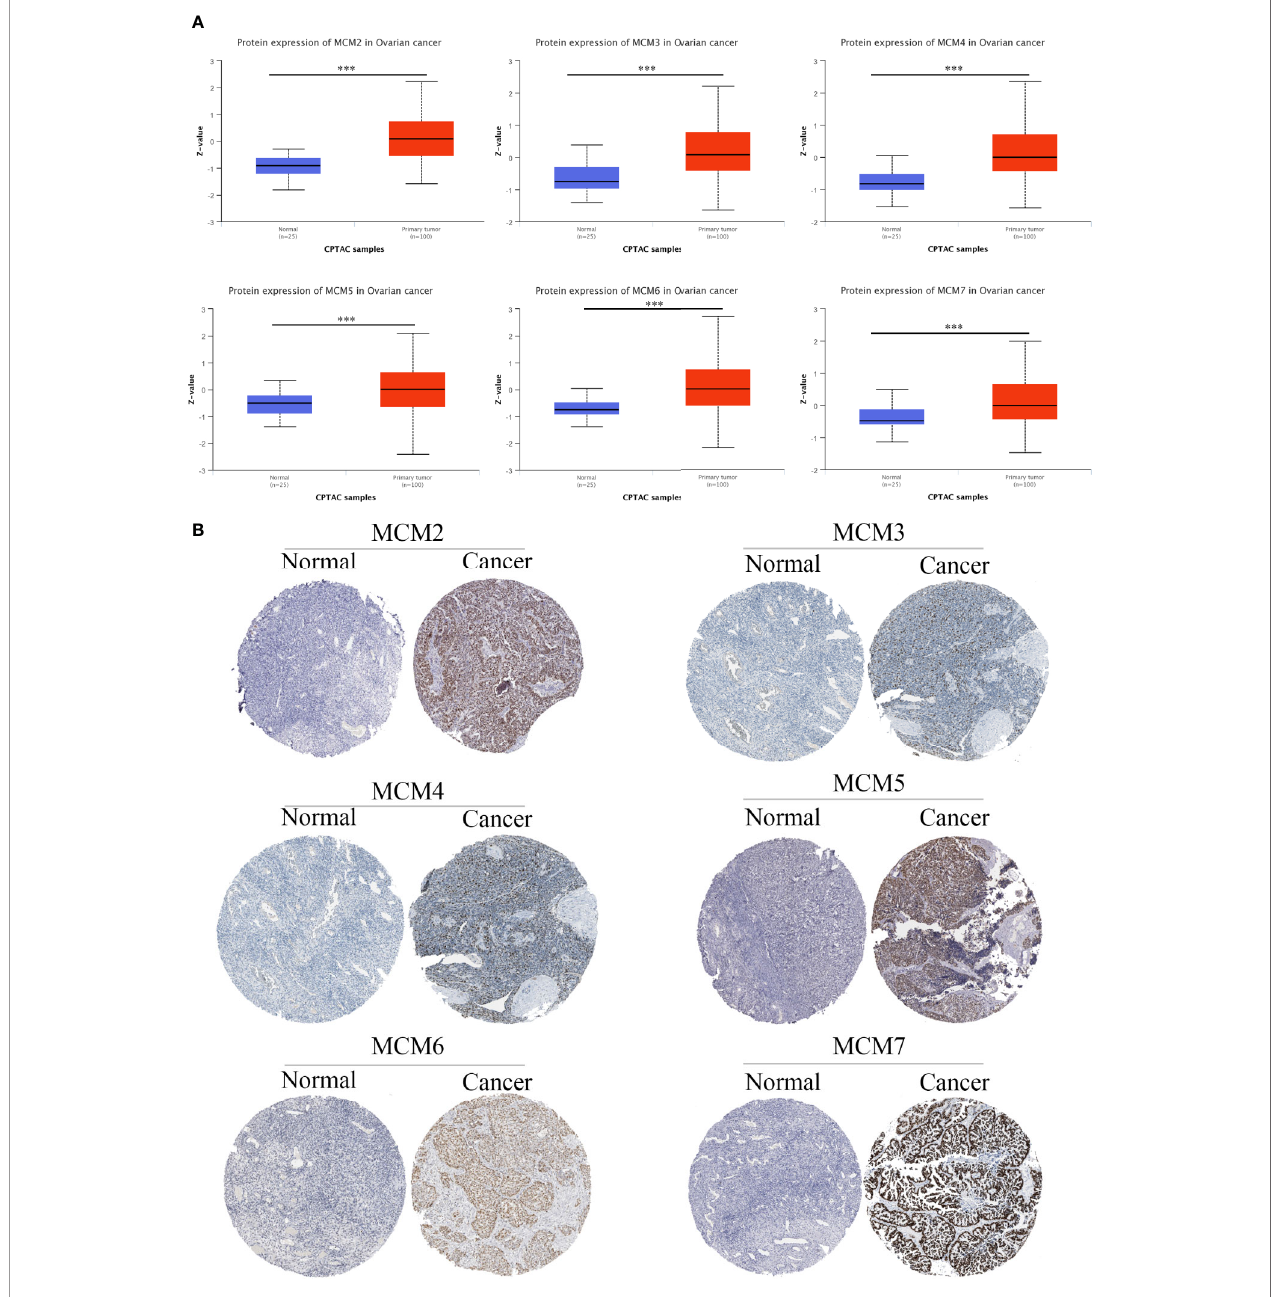
FIGURE 4 | MCM protein expression in OC. The protein expression of the MCM complex in OC based on the CPTAC database (A) and HPA database (B) ***p <